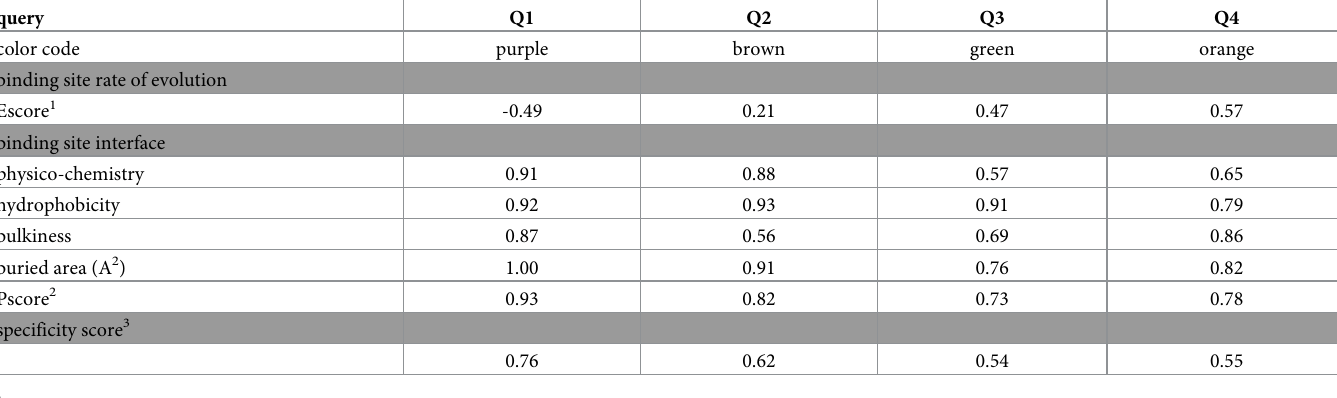
Table 1. Summary of specificity score